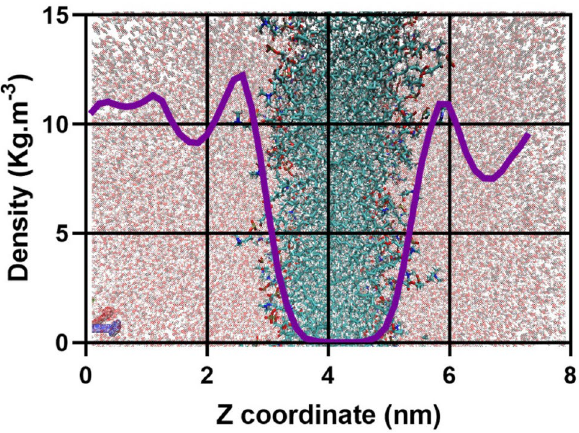
Figure 4. The distribution of divalent cations in the siRNA—membrane system. The purple line is related to the density of Mg ions. In the range of 3–6 nm of z coordinate, the density of Mg ions is around zero because of the hydrophobic region of the membrane.